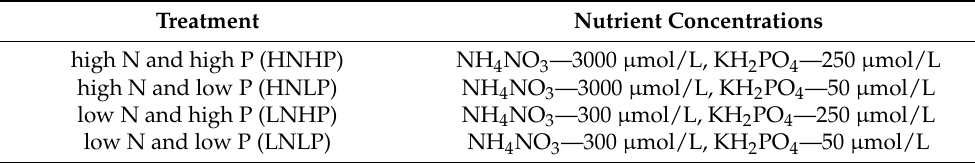
Table 2. The nutrient concentration used for soybean growth experiment.